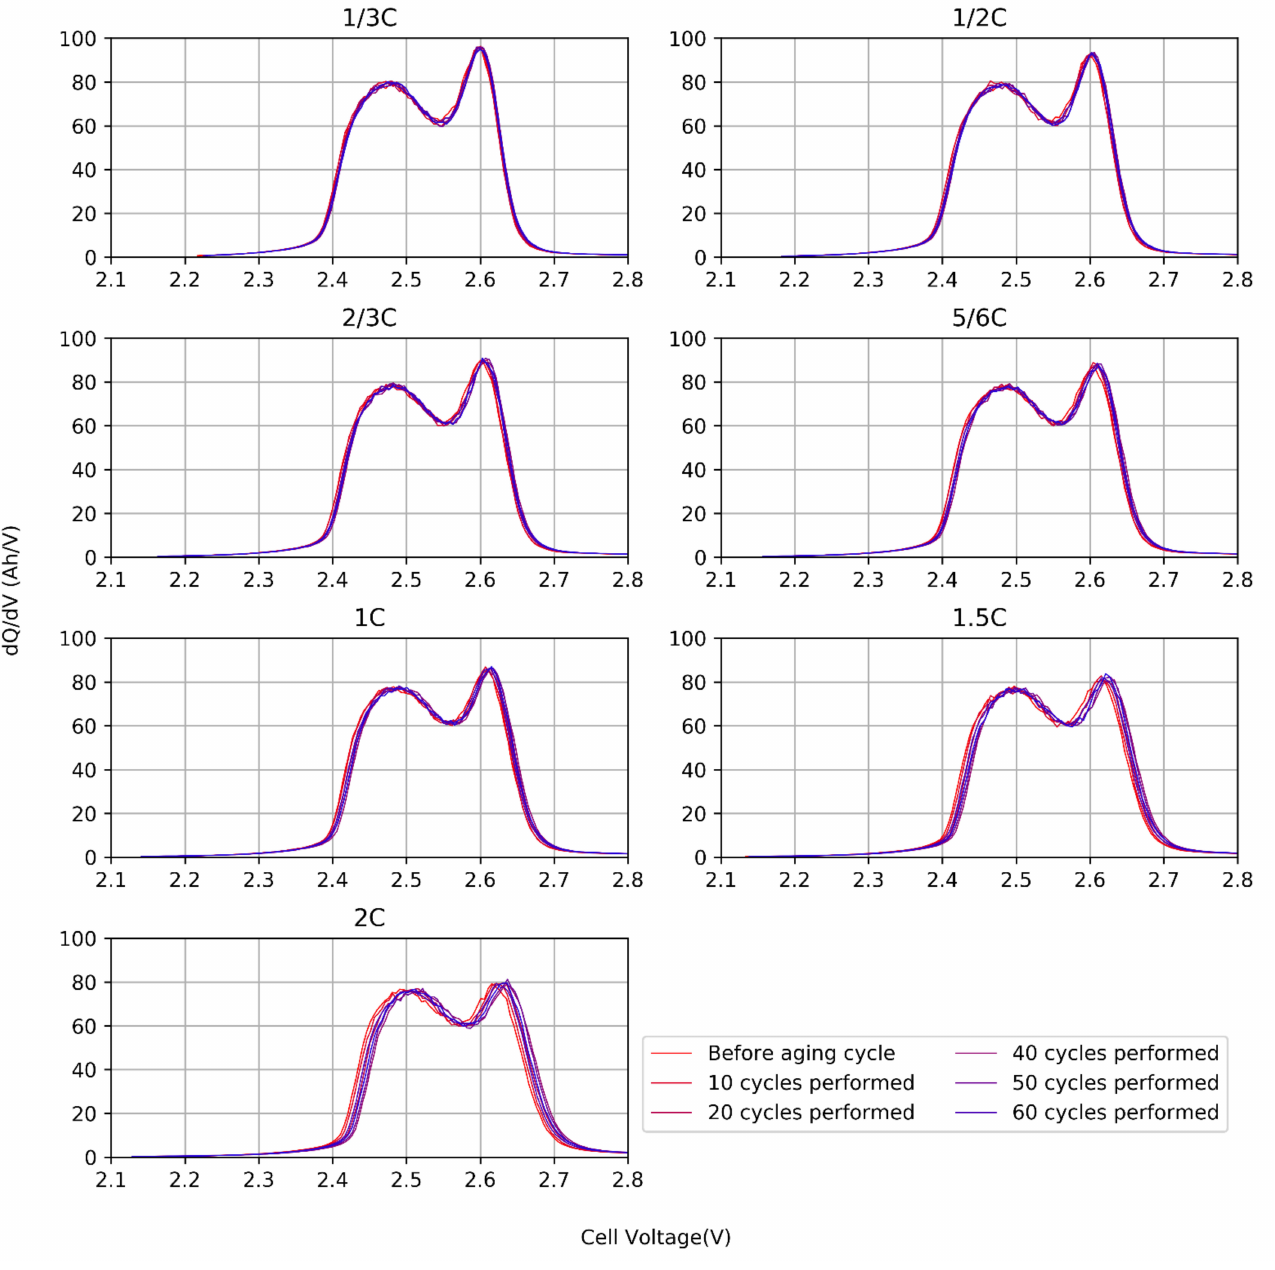
Figure 11. The IC curves of cell #2 at different charging current rate during aging cycles. Figure 11 shows that the IC curves at low current rate (1C or lower) barely changed during aging cycles. At a higher current rate, IC curves tend to move rightward. The IC curves at 2 C are drawn separately in Figure